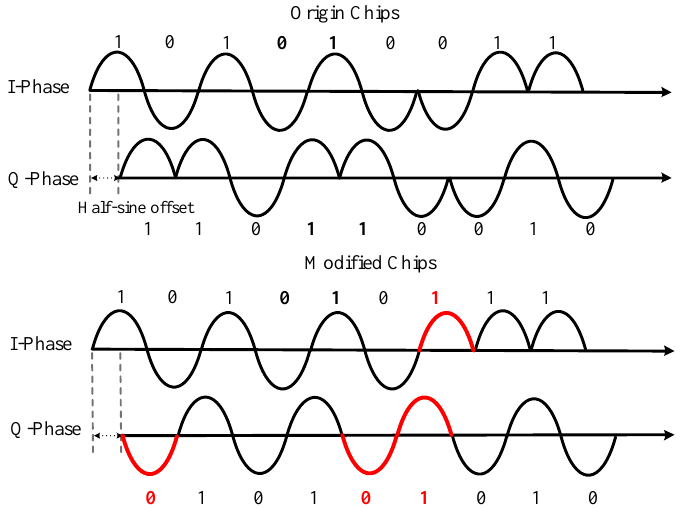
Figure 9. An example of extending the sinusoidal wave by modifying ZigBee chips. Red chips denote the modified